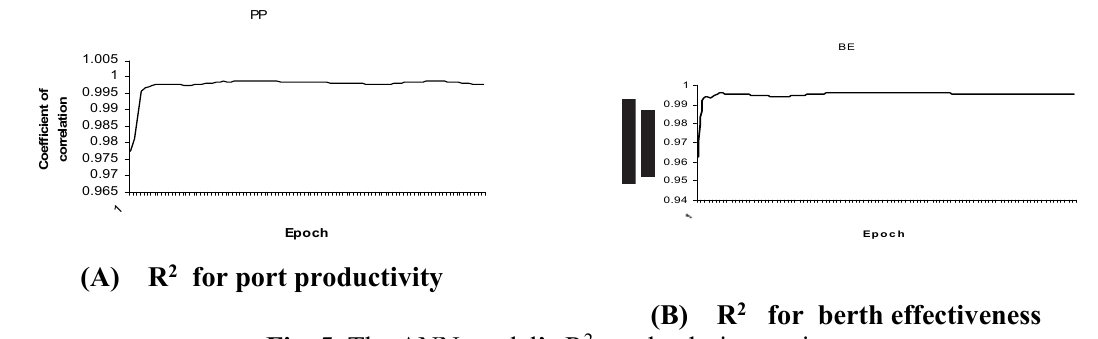
Fig. 5. The ANN model’s R 2 results during testing